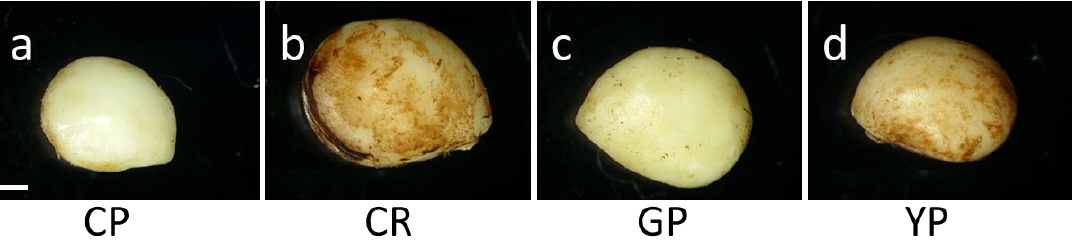
resent significant differences at p ≤ 0.05, as determined by Duncan’s multiple comparison test. CP, Chunpoong; CR, Cheonryang; GP, Gumpoong; YP, Yunpoong.